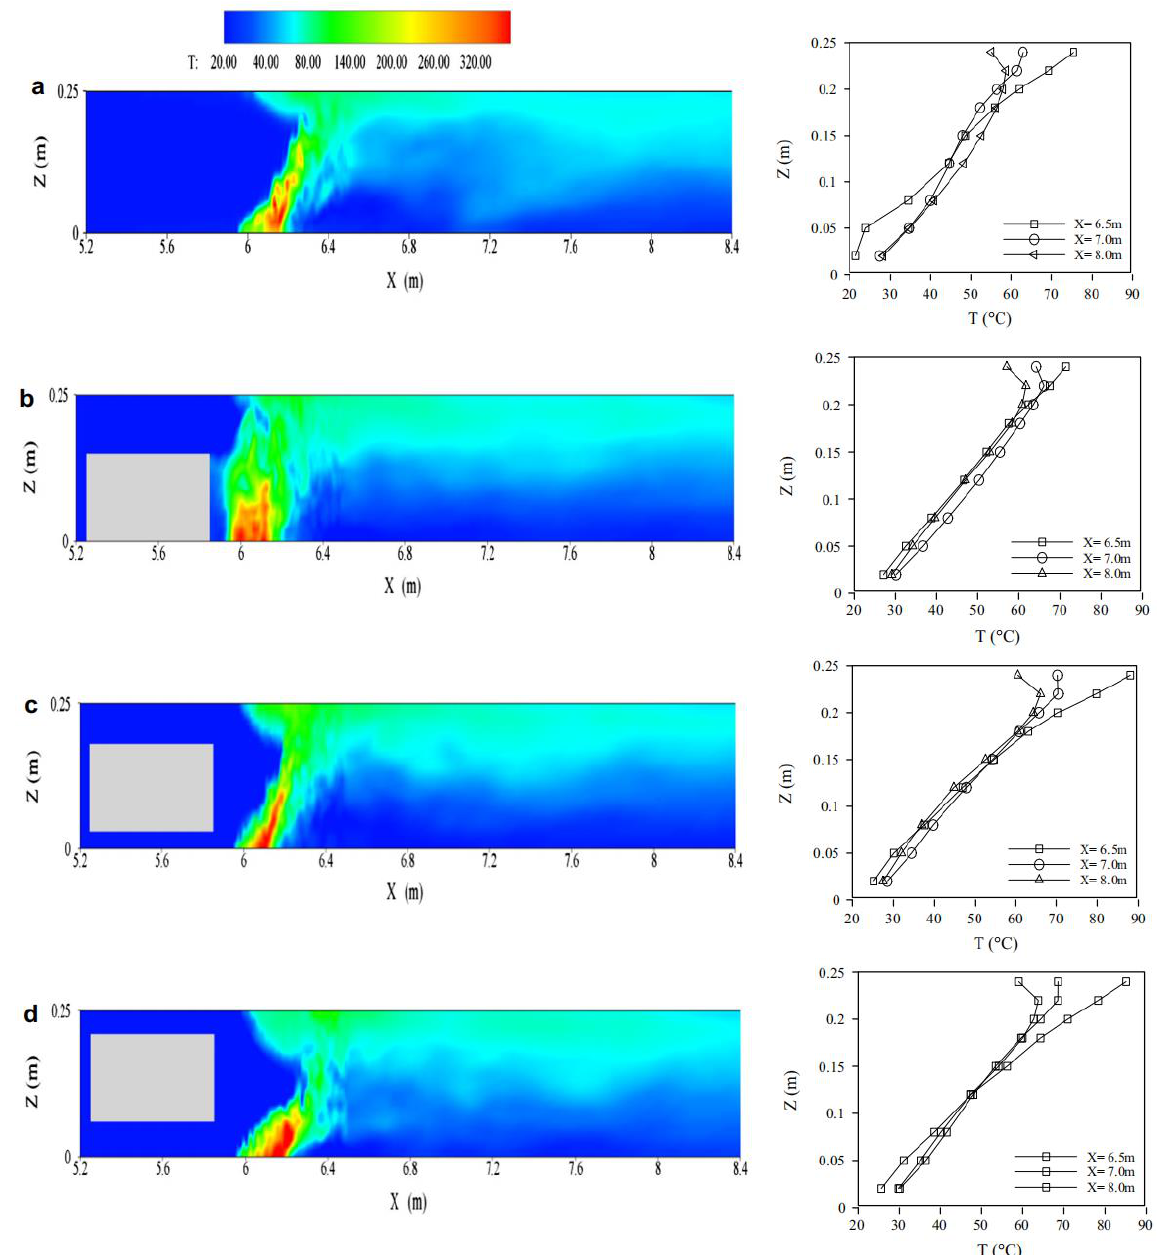
Figure 13. Temperature contours and temperature profiles at critical velocity condition for 1.8 kW fire: a: no obstacle, b: obstacle at 0 m from tunnel floor, c: obstacle at 0.03 m. From tunnel floor 3, d: obstacle at 0.06 m from tunnel floor [49].